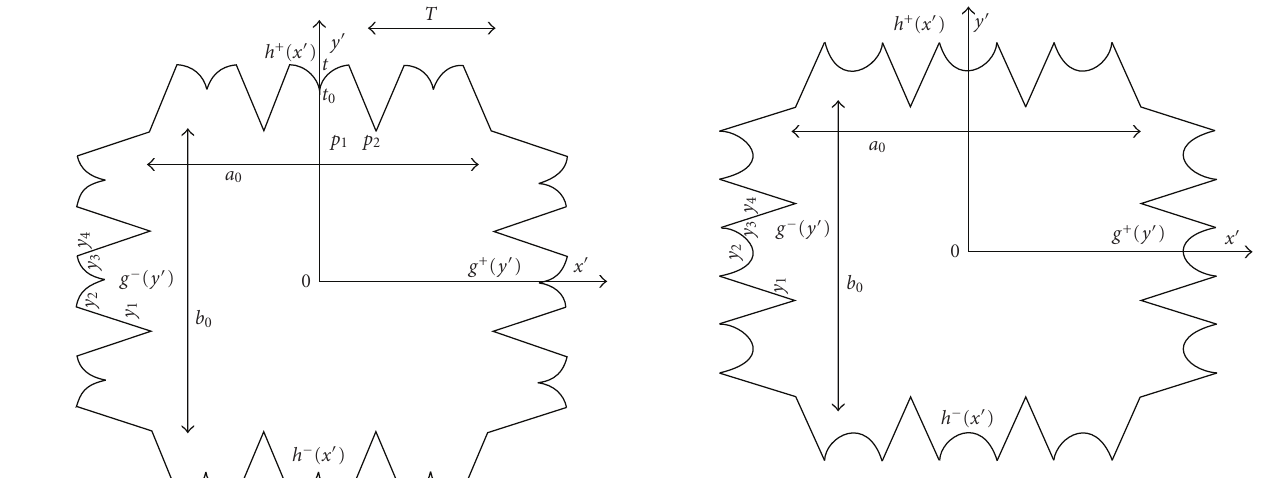
Figure 3: Square aperture reflector with NISE-concave serrations.